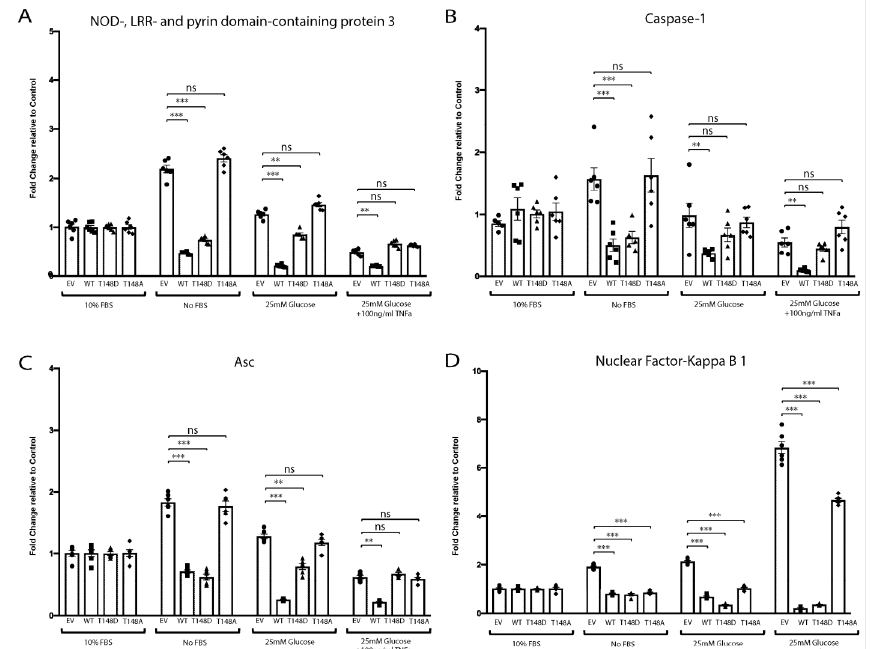
Figure 4. HspB4/ α A-crystallin distinct interaction with inflammatory pathways might play key role in regulating neuro-inflammation in MGCs. Primary Müller cells (HspB4 − / − ) were transfected with either empty vector (EV), wild-type HspB4/ α A-crystallin (WT), phosphomimetic form of HspB4/ α A- crystallin (T148D), or non-phosphorylatable form of HspB4/ α A-crystallin (T148A). Then, 24 h post transfection, cells were either exposed to normal media (10% FBS), serum starvation (no FBS), high glucose (25 mM glucose), or to diabetic like stress (25 mM glucose + 100 ng/mL TNF α ) for 4 h. The mRNA levels of ( A ) NOD-, LRR-, and pyrin-domain-containing protein 3 ( Nlrp3 ); ( B ) caspase-1 ( Casp- 1 ); ( C ) apoptosis-associated speck like protein containing a caspase recruitment domain ( Asc ); and ( D ) nuclear factor-kappa B-1 ( NF-kB1 ) were normalized to the actin-encoding gene Actb . ** p ≤ 0.01, *** p ≤ 0.001, significantly different from the respective EV-transfected cells. The primary Müller cells (HspB4 − / − ) were used up to passage 4 for the experiments. Each endpoint was measured on a minimum of six technical replicates. Statistical analysis was performed by one-way ANOVA followed by Student–Newman–Keuls